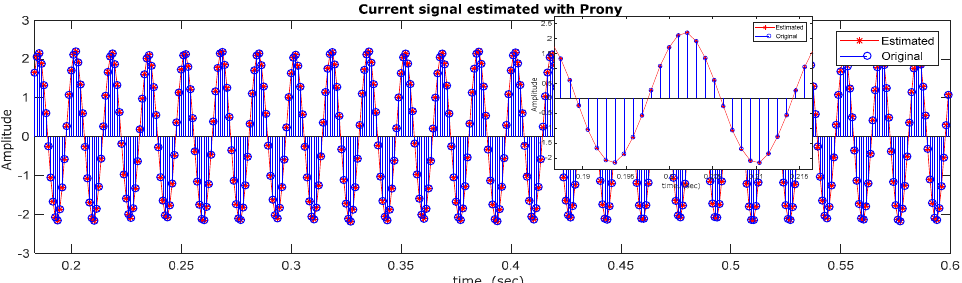
Figure 17. Sliding data window (Prony estimated and original signal) of 25 cycles of current signal measurement of motor line current of phase A at 60 Hz operation. Table 6. Measured current signal estimated